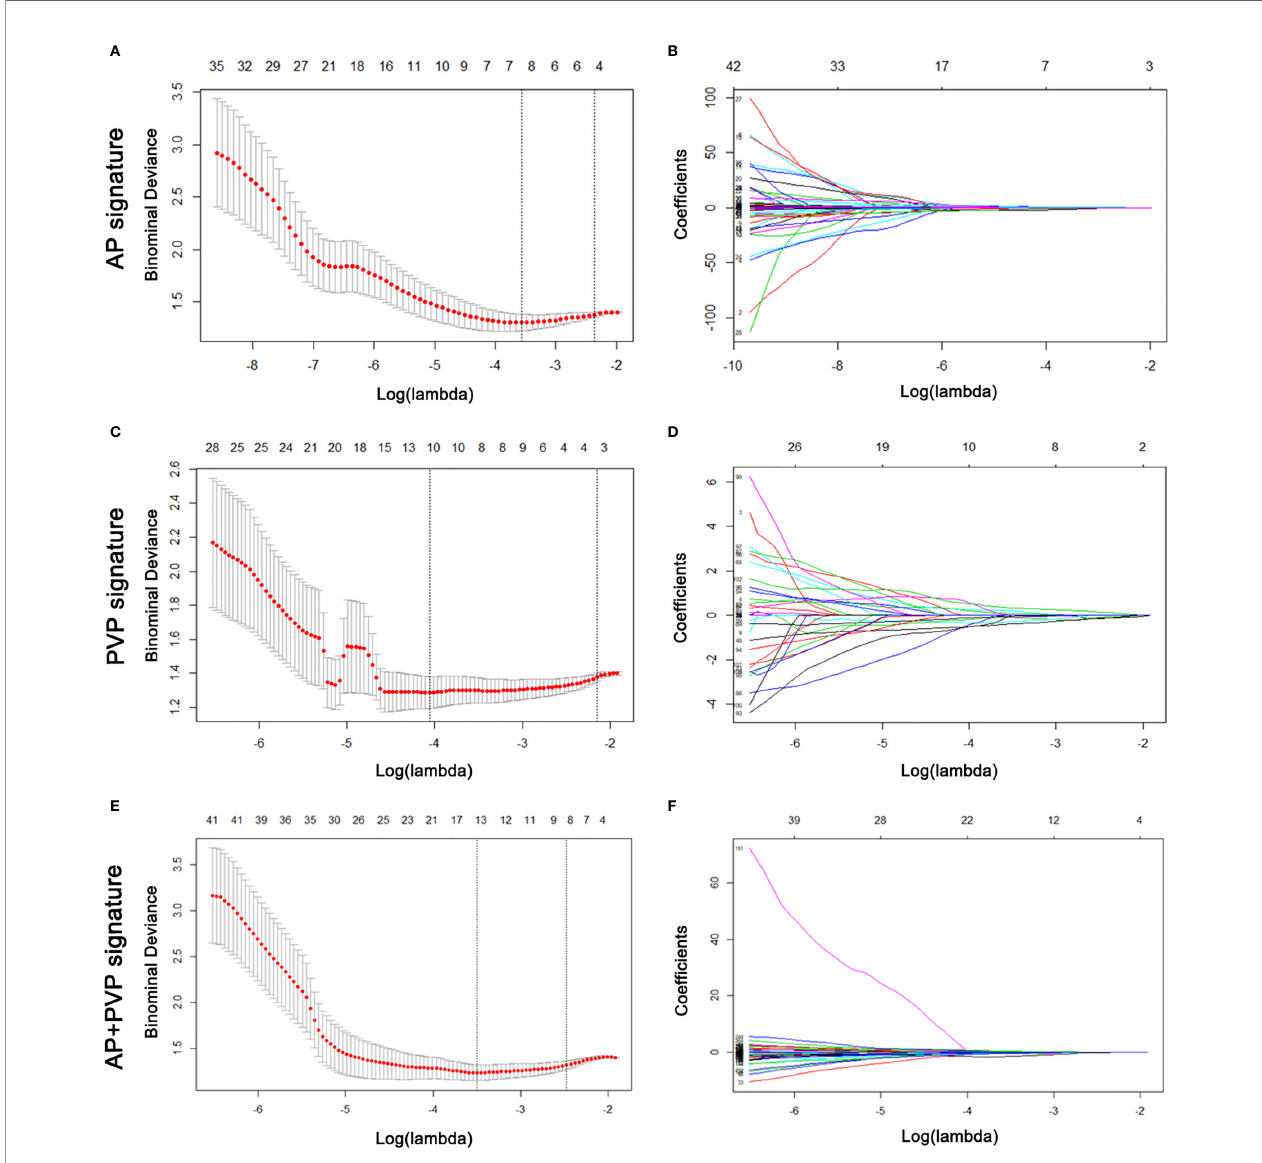
FIGURE 3 | AP, PVP, and AP+PVP radiomics feature selection by LASSO regression. (A, C, E) Selection of tuning parameters (lambda value) in the LASSO model using ten-fold cross-validation by the minimum criteria. (B, D, F) LASSO coef fi cient pro fi les of the radiomics features. LASSO, least absolute shrinkage and selection operator; AP, arterial phase; PVP, portal vein